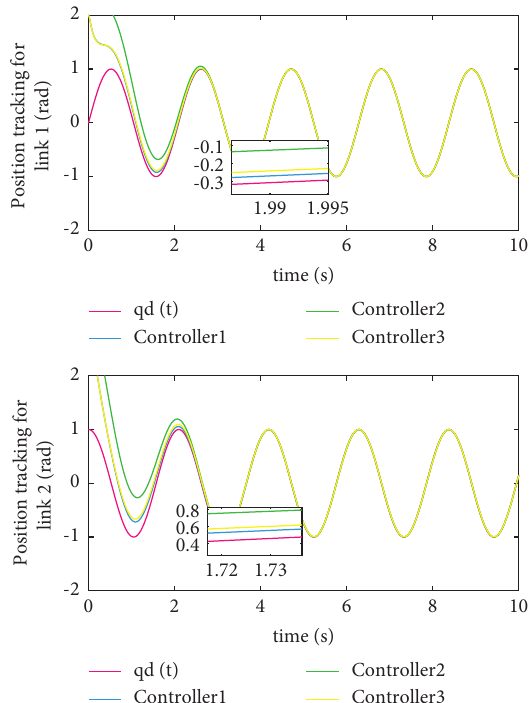
Figure 1: Comparison of manipulator trajectory tracking.